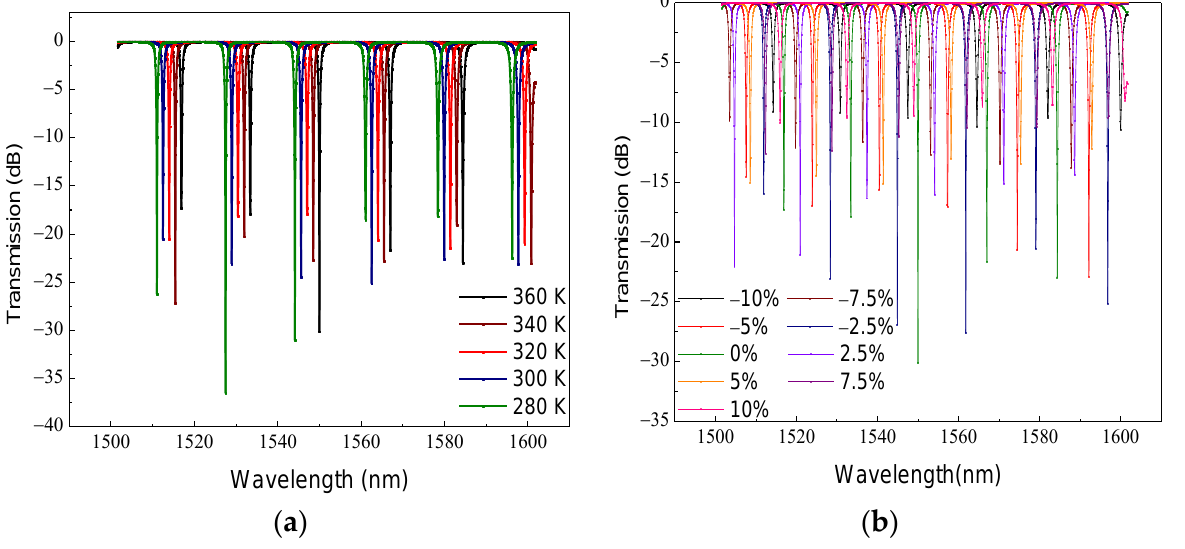
Figure 6. ( a ) The resonant wavelength shifts with the temperature variation; ( b ) the resonant wavelength shifts with the line width variation.